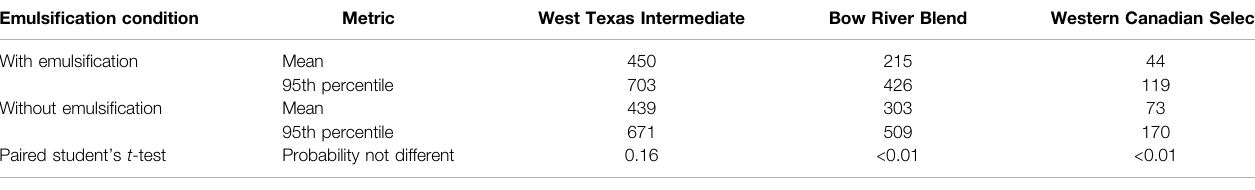
TABLE 5 | Expected water volumes (million m 3 ) exposed to dissolved concentrations ≥ 1 μ g/L for a surface release of 200 MT, based on results for 114 simulations varying spill date.